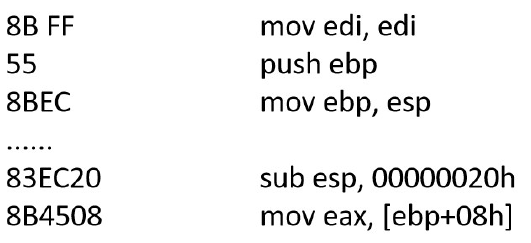
Figure 5. Decompiling codes of a binary byte sequence.